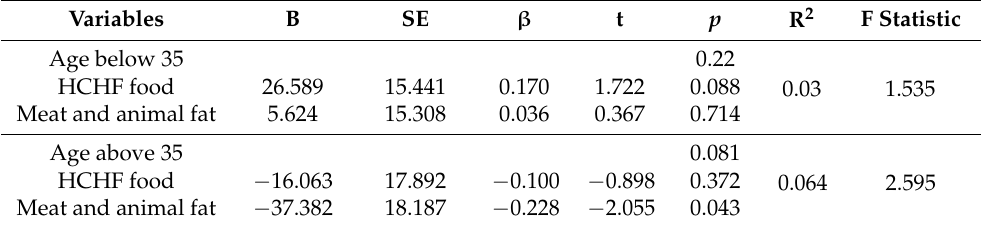
Table 6. Explanations of the interaction effects (age × HCHF food and age × meat and fat age) show- ing a simple effect for younger and older age groups on SynWin multitasking performance predicted by the frequency of HCHF food consumption and meat and animal fat frequency